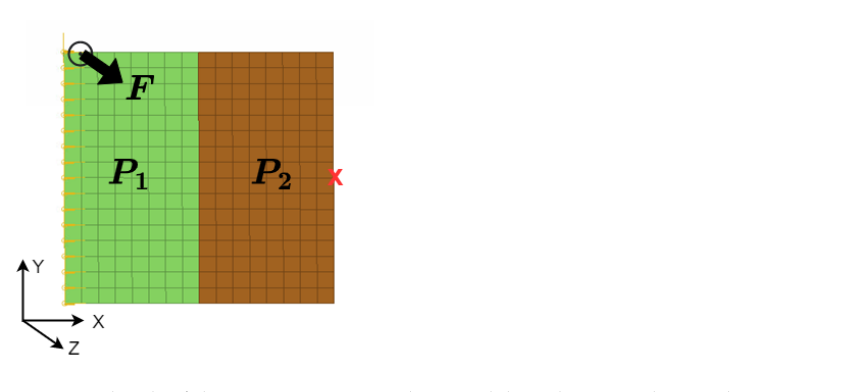
Figure 1. Sketch of the two-component plate model. Red cross indicates the output node